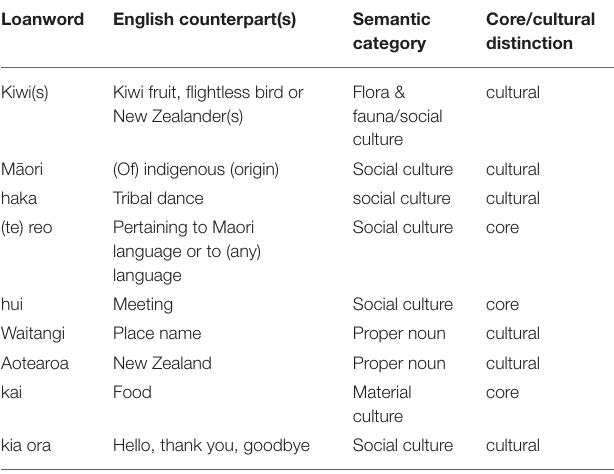
TABLE 2 | Linguistic characteristics of the M¯aori loanwords used in hybrid